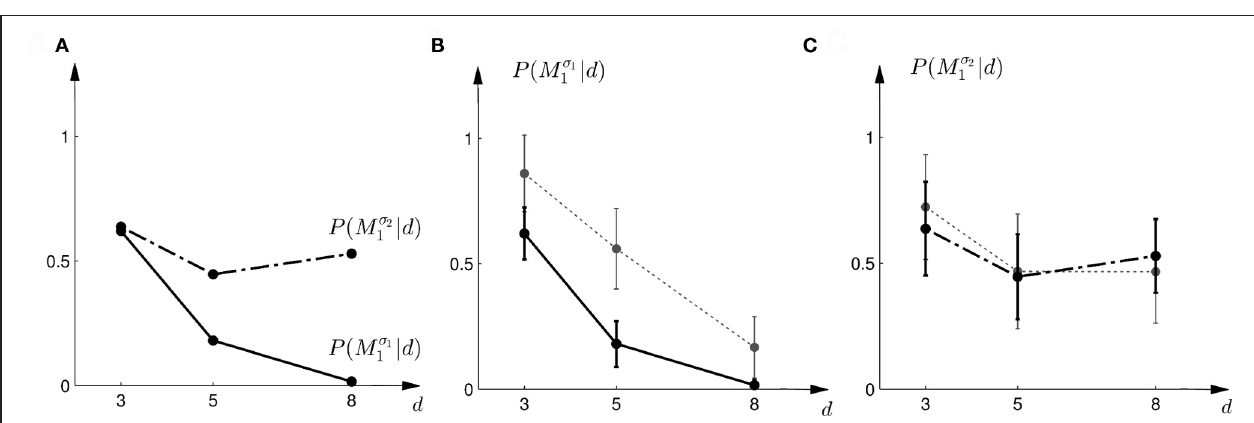
individually per subject, the predictions show the mean across all subjects. The corresponding standard deviation error bars are shown in panels (B,C) . (B) Shows the predictions for the first part of the study (solid line) and the experimental results for three different widths d of the ambiguous feedback array. The dotted line shows the mean and standard deviation across subjects of the experimentally observed probabilities of choosing M σ 1 1 . (C) Shows the predictions (dash-dot line) as well as the experimentally observed choice probabilities (dotted line) for choosing M σ 2 1 in the second part of the